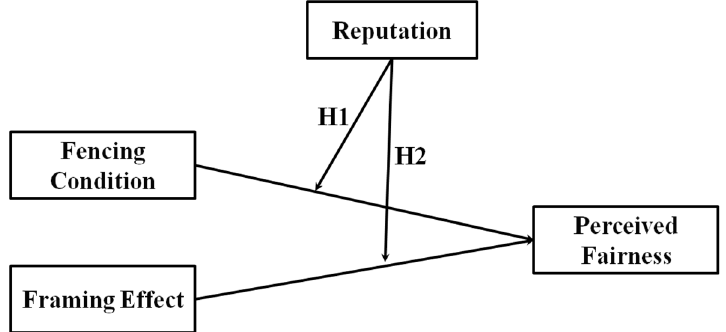
Figure 1. Proposed research model. Notes 1: H1 = Hypothesis 1; Notes 2: H2 = Hypothesis 2.